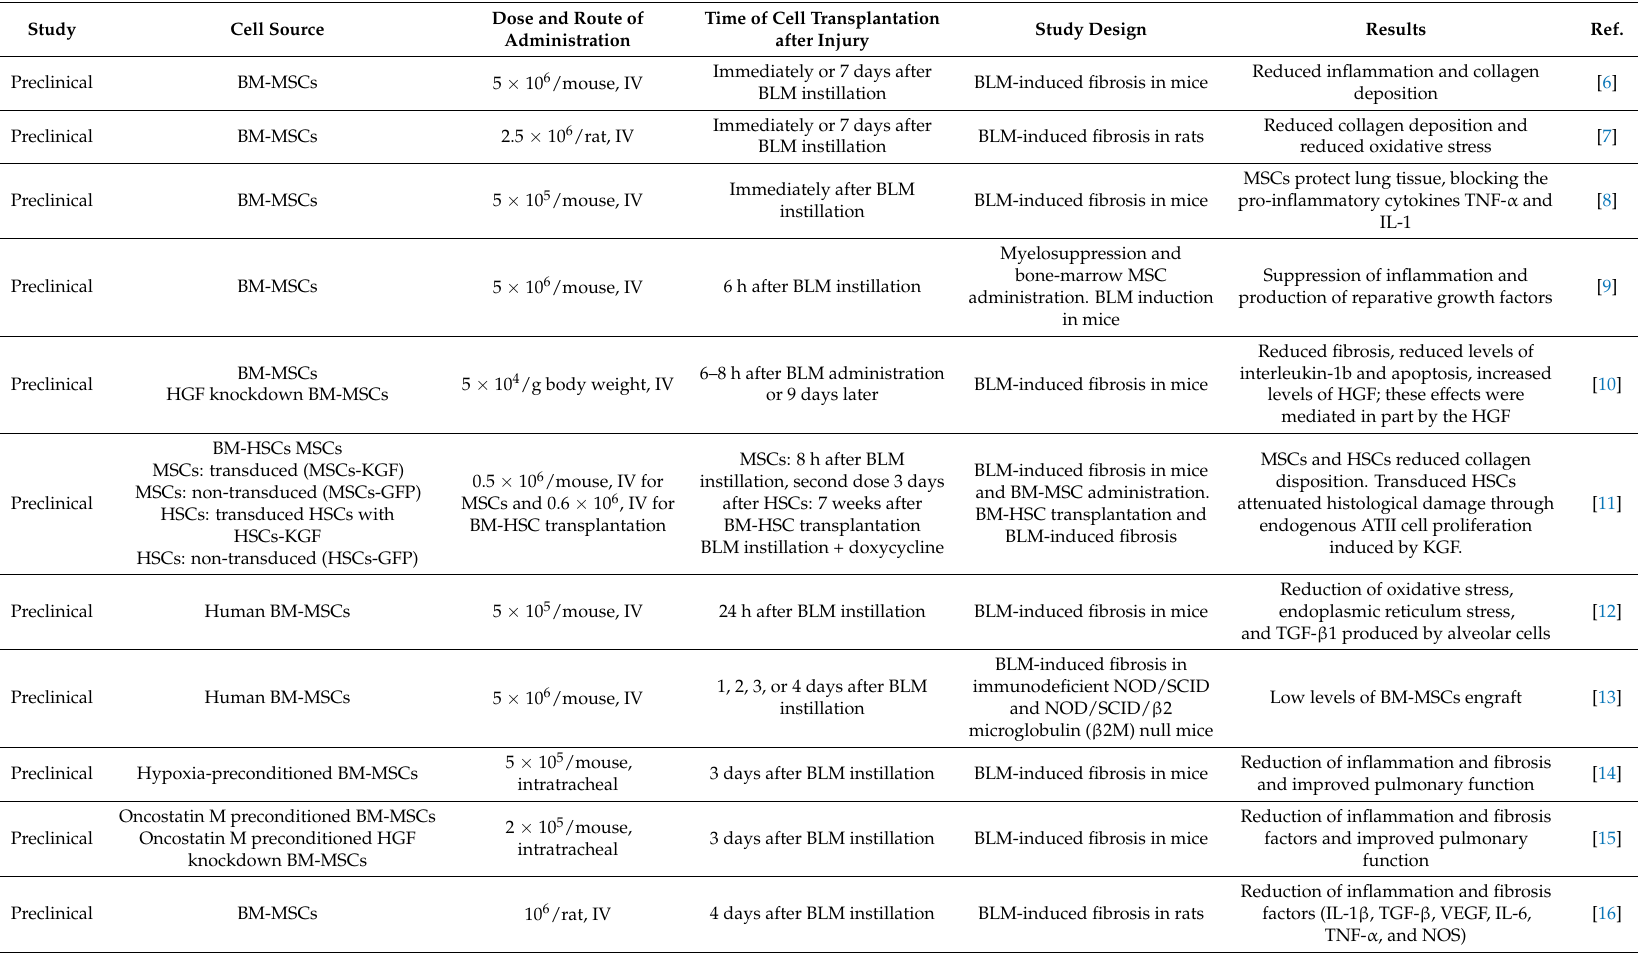
Table 1. Results of preclinical and clinical studies of cell-based therapies for idiopathic pulmonary fibrosis